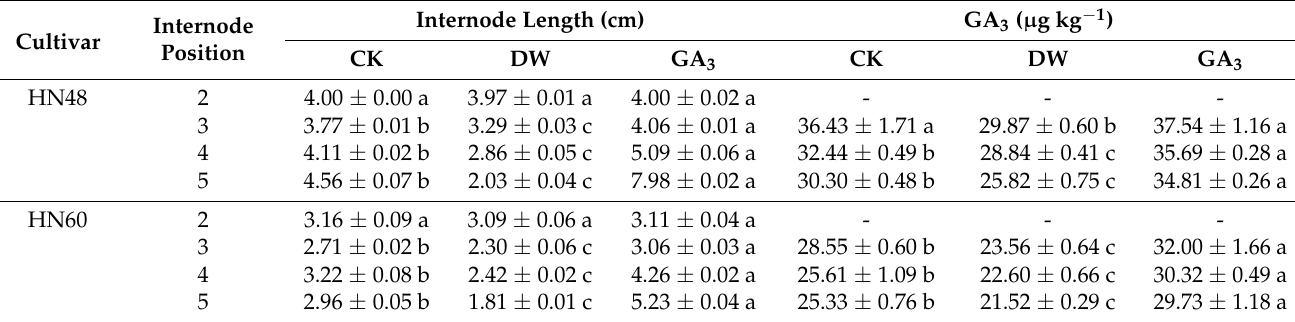
Table 5. Effects of GA 3 application on soybean internode length and stem GA 3 content after apical meristem removal.